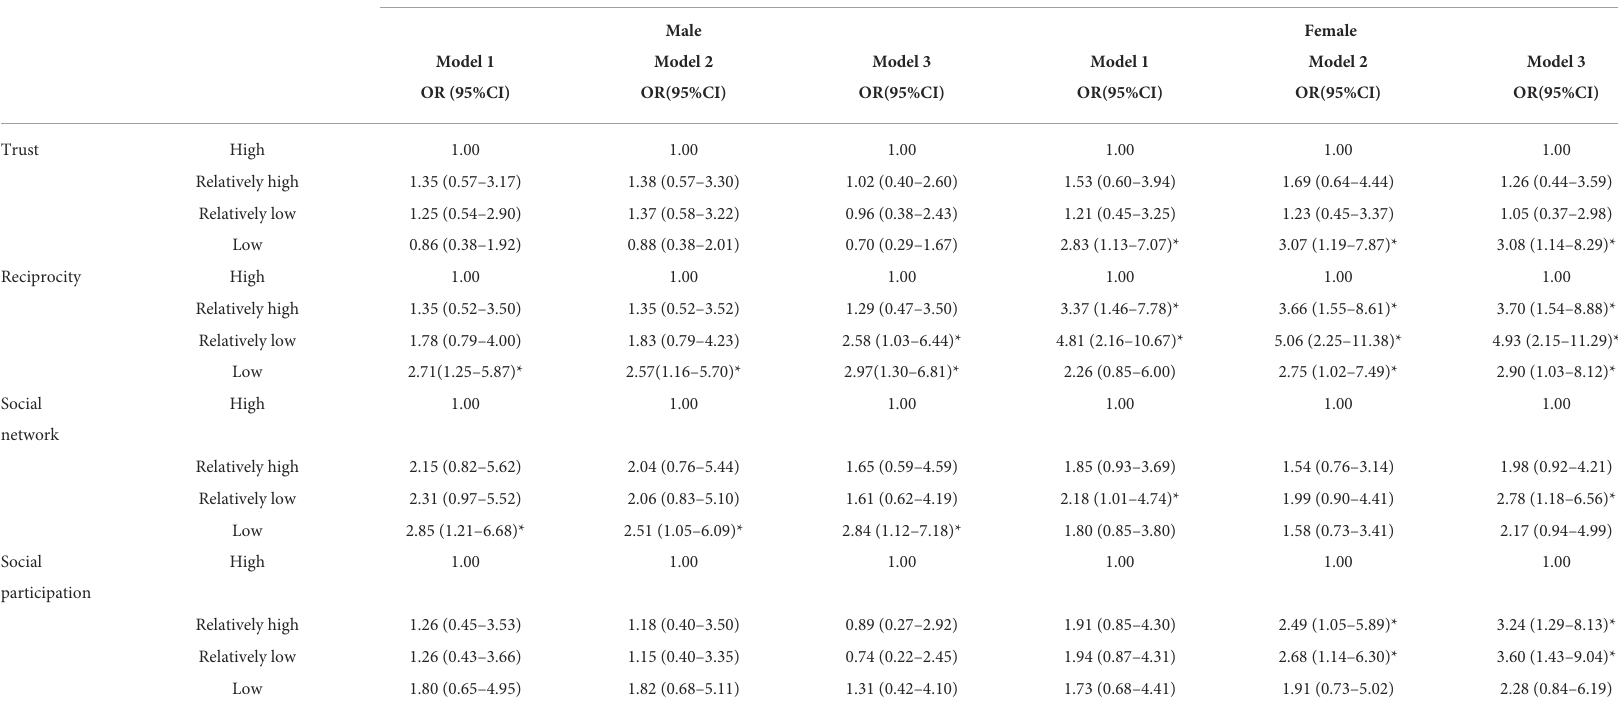
TABLE 5 Impact of social capital on